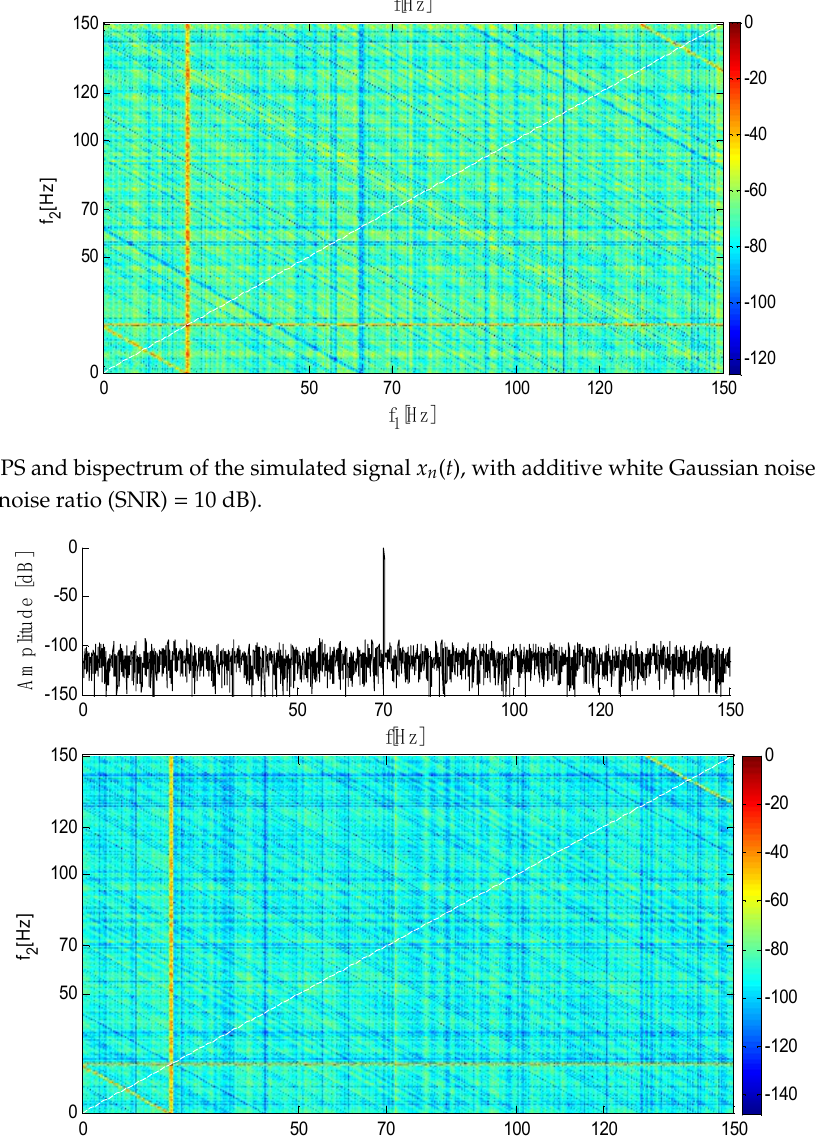
Figure 8. PS and bispectrum of the simulated signal x n ( t ), with AWGN (SNR = 20 dB).